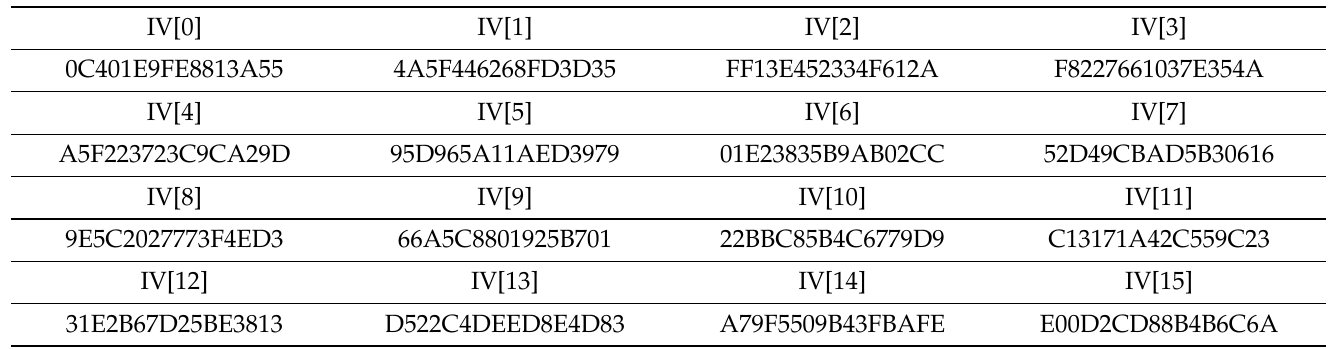
Table 2. Initialization vector (IV) for LSH-512-224 in hexadecimal.